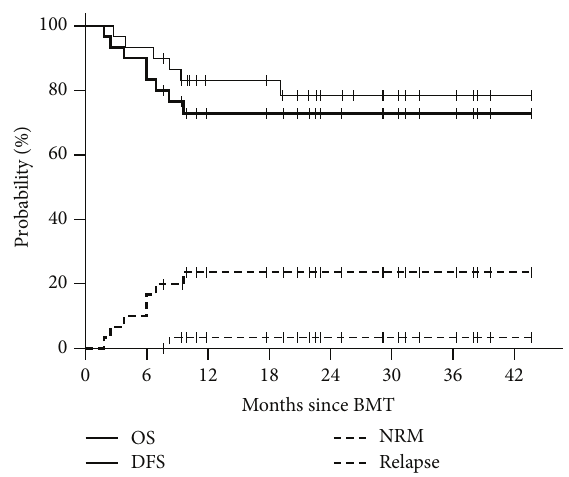
Figure 1: Kaplan-Meier analysis of overall survival, disease-free survival, and nonrelapse mortality and following TBI-based MA